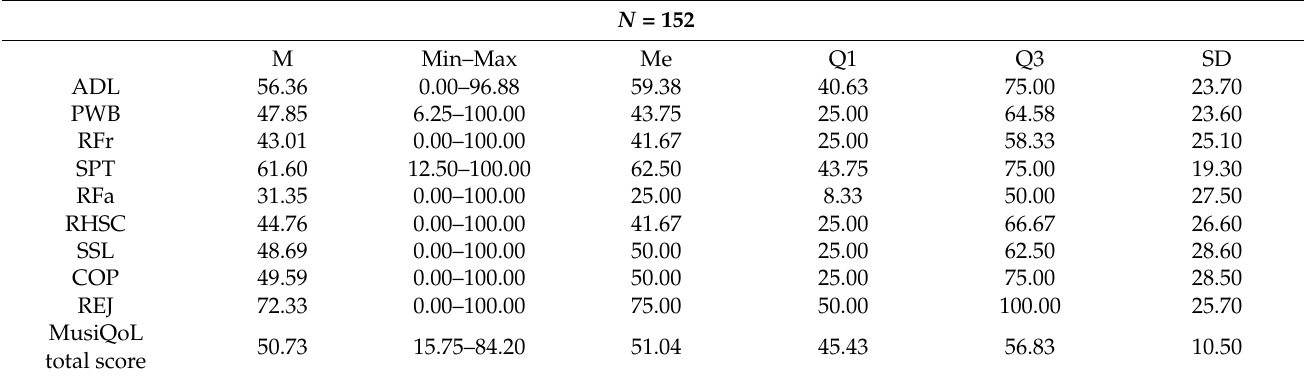
Table 2. Assessment of the overall quality of life and the individual MusiQoL domains. N =